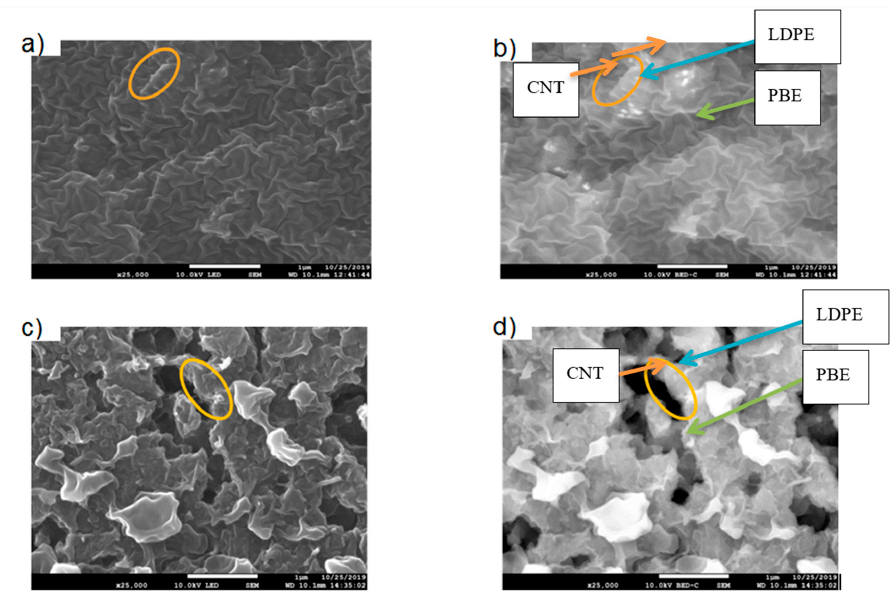
Figure6. SEMimagesincrosssectionofthe40 ( LDPE KB 10 CNT 5 ) /60PBEand60 ( LDPE KB 10 CNT 5 ) /40PBE blends: location of CNT nanoparticles. ( a , c ) are in normal LED mode and ( b , d ) are in backscattered mode. LDPE is whiter and PBE is